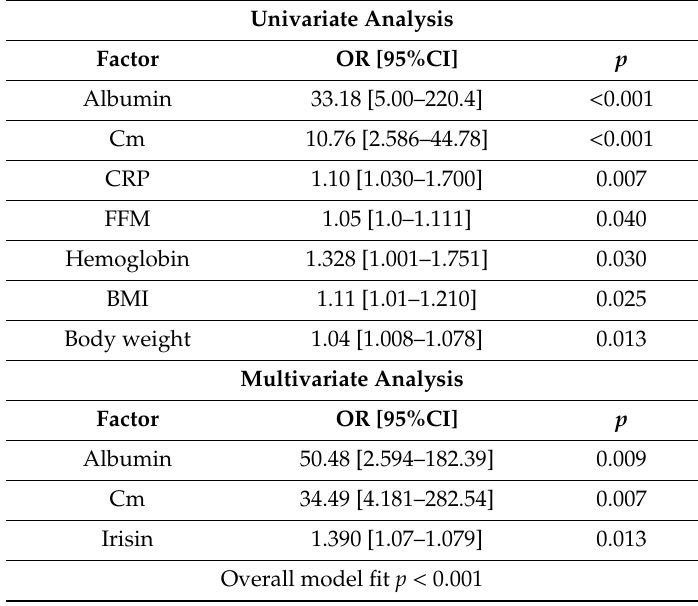
Table 4. Factors selected by uni- and multivariate logistic regression analysis, that significantly a ff ected cachexia in CHF female patients.